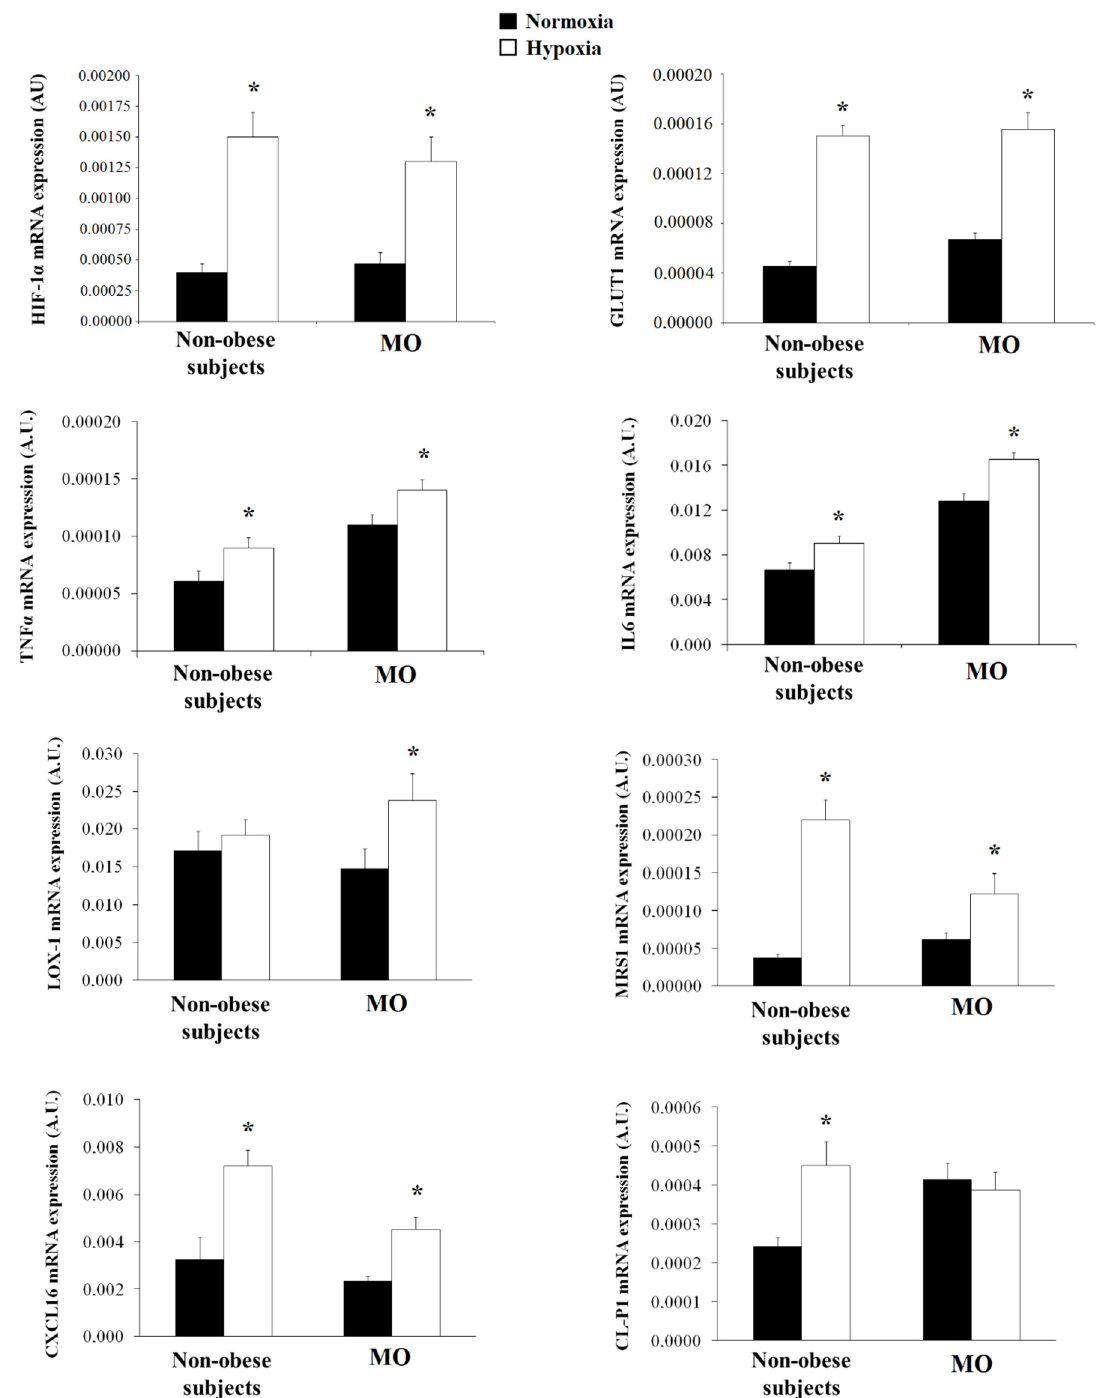
Figure 5. Levels of HIF-1 α , GLUT1, IL6, TNF α and scavenger receptors mRNA expression of in vitro-differentiated adipocytes obtained from human mesenchymal stem cells of visceral adipose tissue (VAT) from non-obese subjects ( n = 5) and patients with morbid obesity ( n = 5) (MO) incubated in normoxia ( (cid:4) ) and hypoxia ( (cid:3) ) conditions for 24 h. Each treatment was performed in triplicate. Data are the mean ± SEM. * p < 0.05: significant differences between the normoxia and hypoxia conditions.